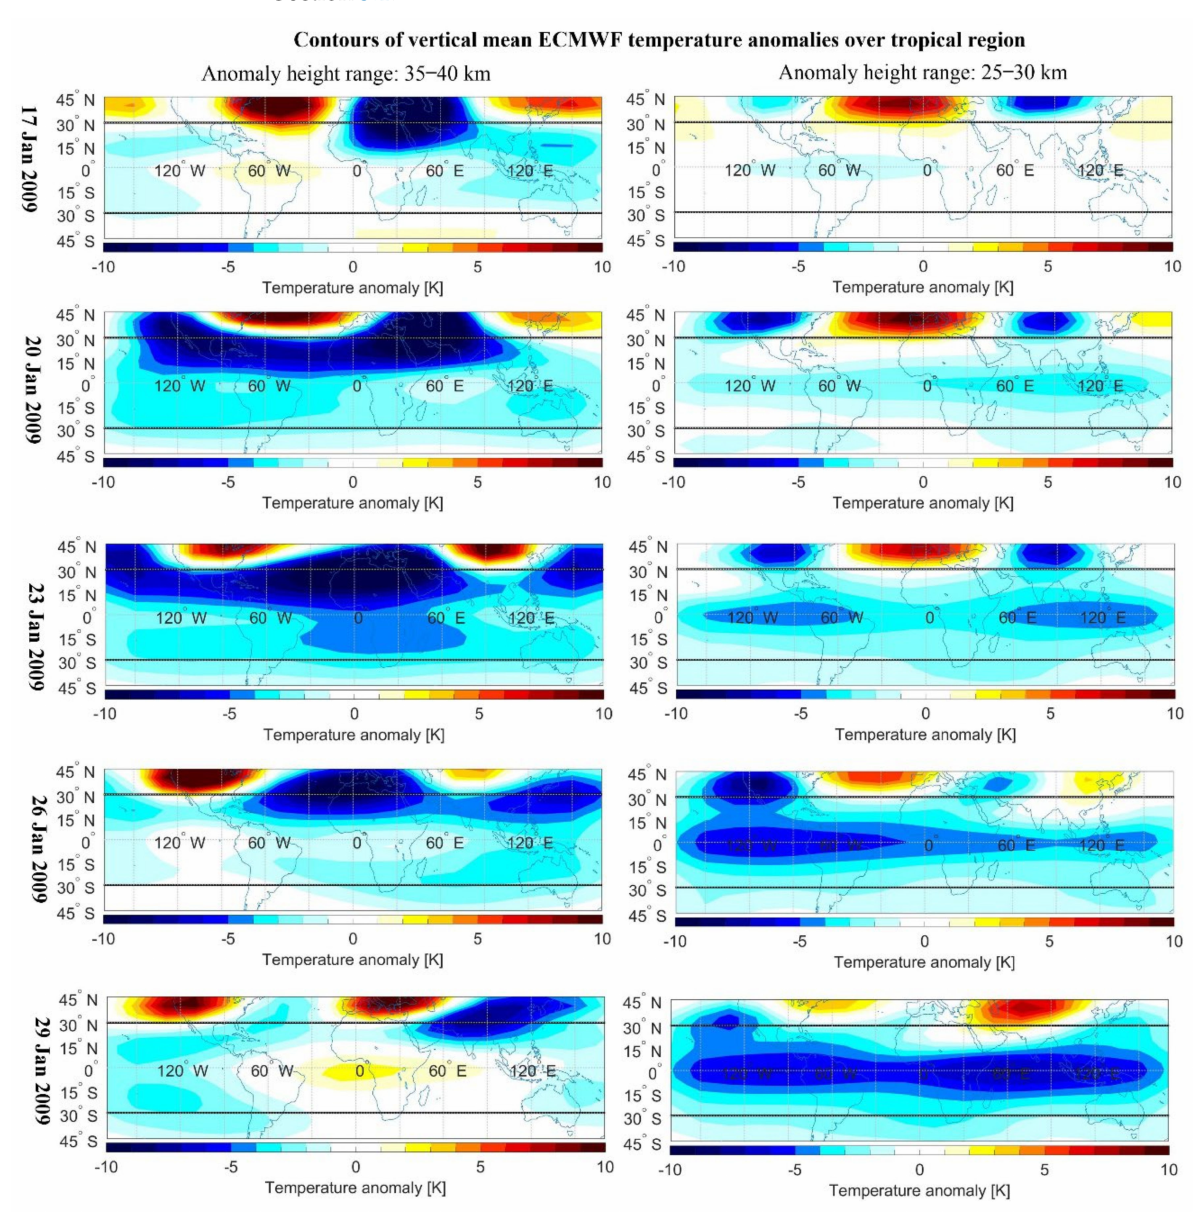
Figure 7. Latitude and longitude sectors of gridded mean ECMWF temperature anomalies obtained from response altitude layer 35–40 km (left panels) and from downward altitude layer 25–30 km (right panels) on five exemplary days of 17, 20, 23, 26, and 29 January